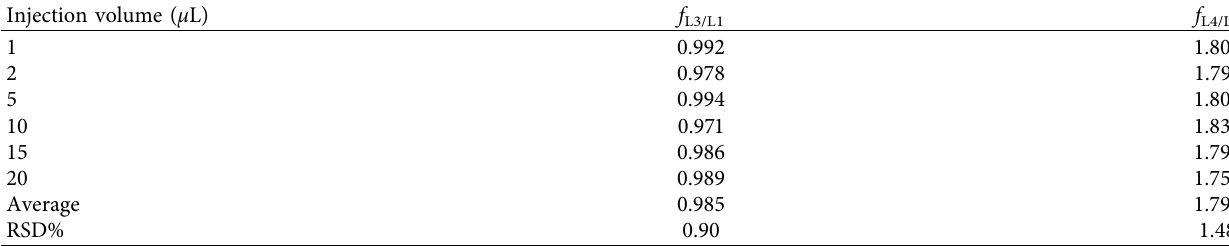
Table 5: Relative correction factor of two components.